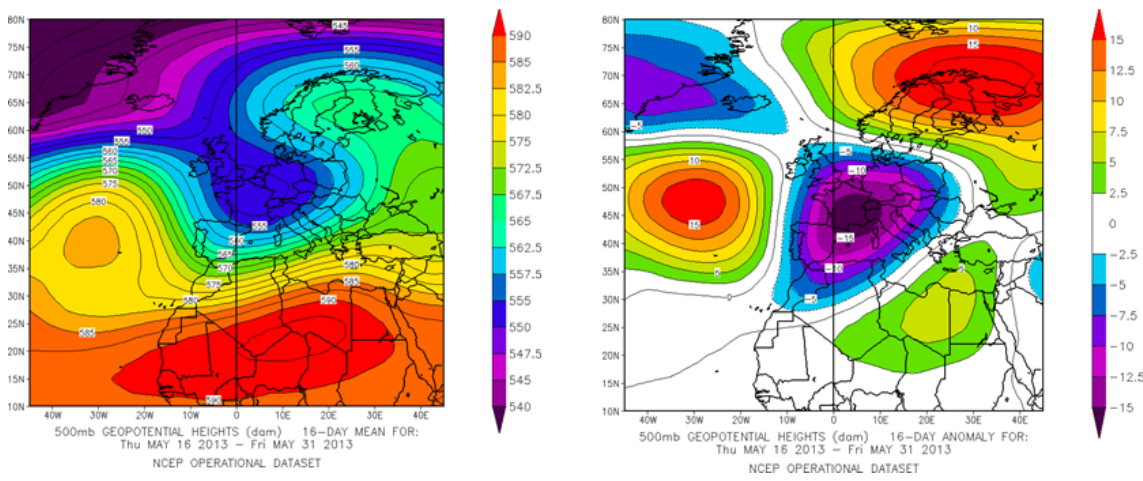
Figure 1. 500hPa geopotential height, 16 day mean for 16–31 May 2013 (left) and anomaly in respect to the climatology based on 1979– 1995 (right). Credit: Data/image provided by the NOAA/OAR/ESRL PSD, Boulder, CO, USA, from their Web site at http://www.esrl.noaa. gov/psd/ (last access: 4 April